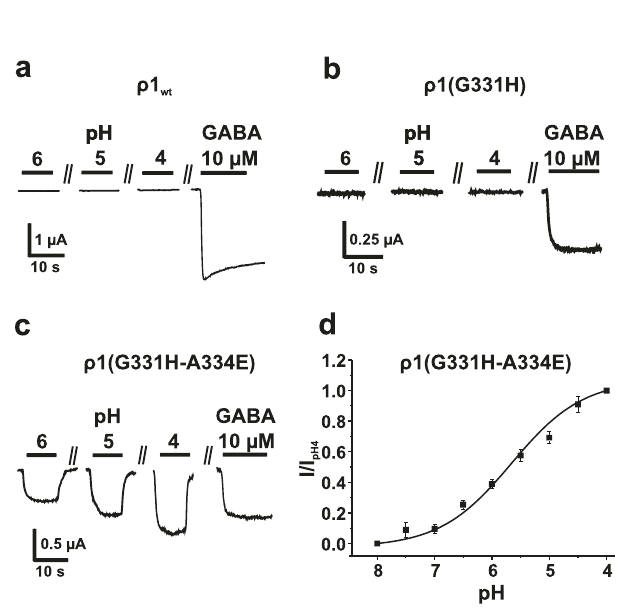
Fig. 4 Gain of function mutations in GABA A ρ 1(G331H-A334E) subunit homomers. a Homomers of wild type ρ 1 subunits are insensitive to protons but activated by GABA (10 µ M, pH 7.2). b , c A single point mutation ρ 1(G331H) was ineffective while double mutation ρ 1(G331H-A334E) transferred proton sensitivity. d Normalized peak current values of I H( ρ 1G331H-A334E) at indicated pH fi tted to the Hill equation (pH 50 = 5.66 ± 0.1, n H = 0.7 ± 0.12). The data are presented as mean values ±SEM, n = 9. pH changes in all experiments from 9 to indicated